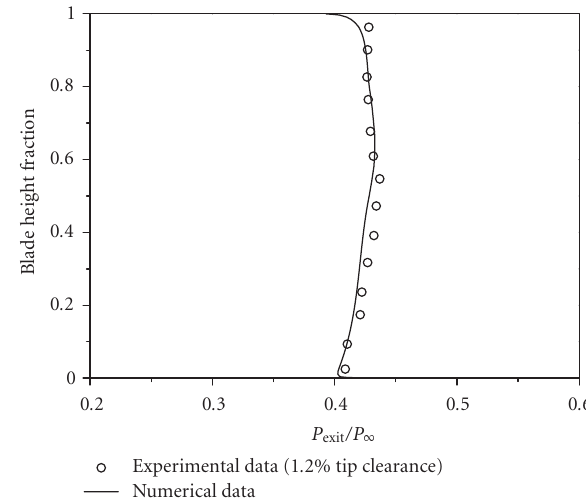
Figure 6: Total pressure distribution at the outlet of the turbine.